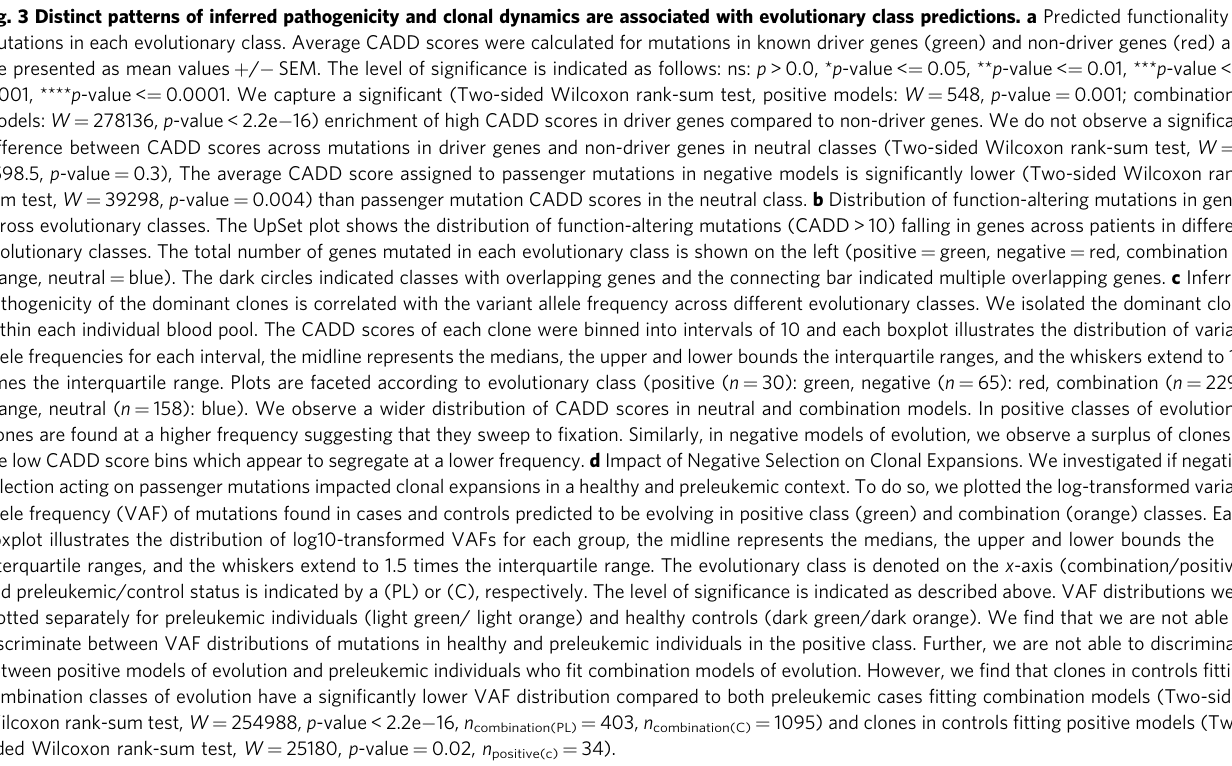
NATURE COMMUNICATIONS| (2021) 12:4921